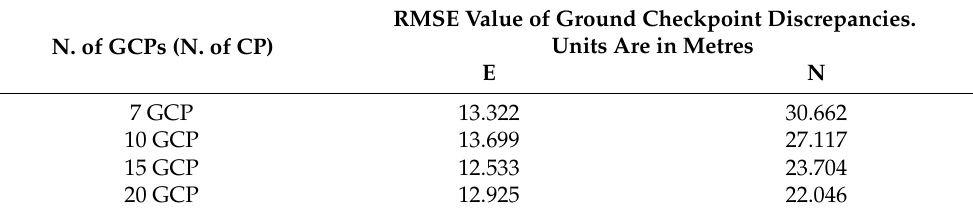
Table 4. Results of rigorous model for Rome test field. RMSE Value of Ground Checkpoint Discrepancies. Units Are in Metres N. of GCPs (N. of CP) E N 7 GCP 13.322 30.662